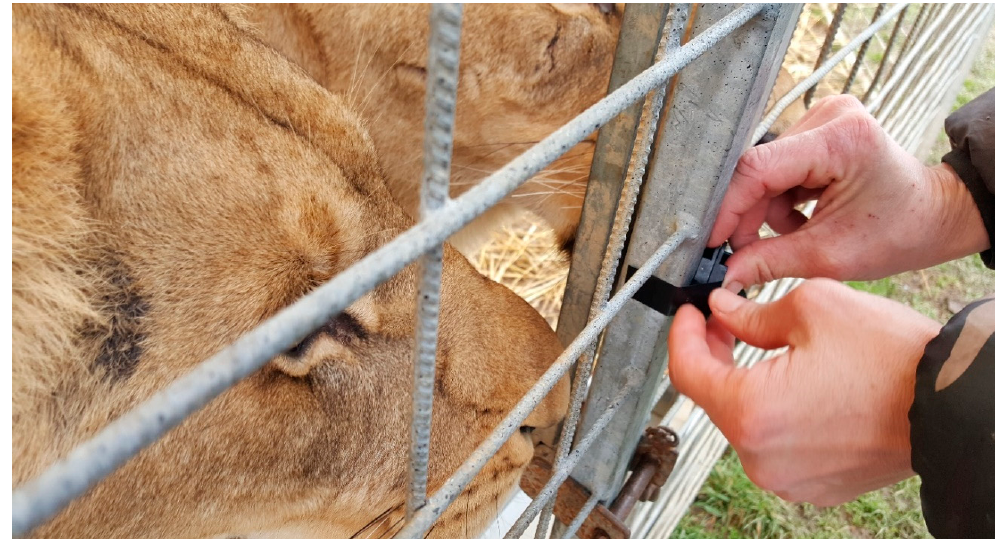
Figure 4. Attaching a Thermochron to the outside of Group 3 ′ s exercise pen to record ambient temperature. The logger was not placed directly against the steel cage.